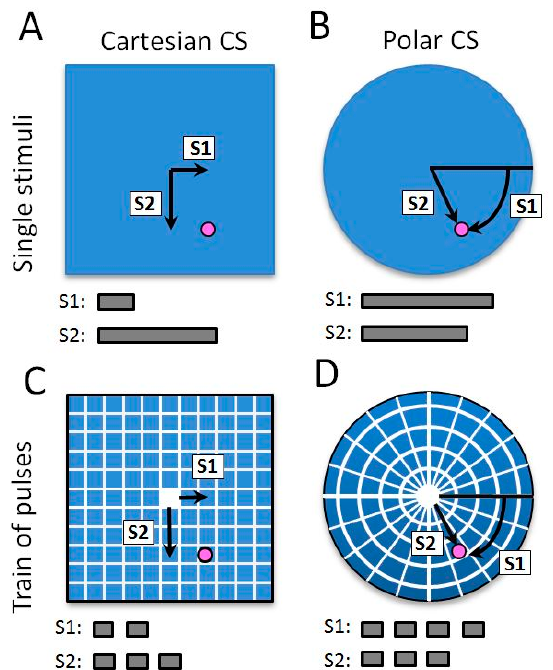
Figure 1. Tactile coding of one target (pink dot) with the four different techniques. Two different tactile codes are used: single stimuli ( A , B ) and train of pulses ( C , D ). The target coordinates were either rendered in a Cartesian coordinate system ( A , C ) or in a Polar coordinate system ( B , D ). The two coordinates (azimuth and elevation) are rendered with two successive stimulations (S1, S2). Stimulations are represented with grey bars. In this experiment, the target locations were randomly selected in the whole blue zone.